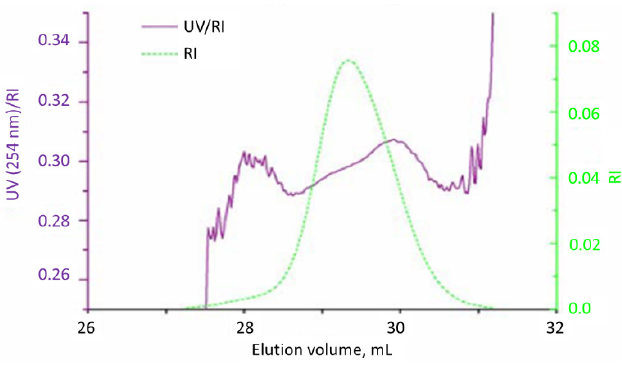
Figure 5. SEC elugram of Sample A1.